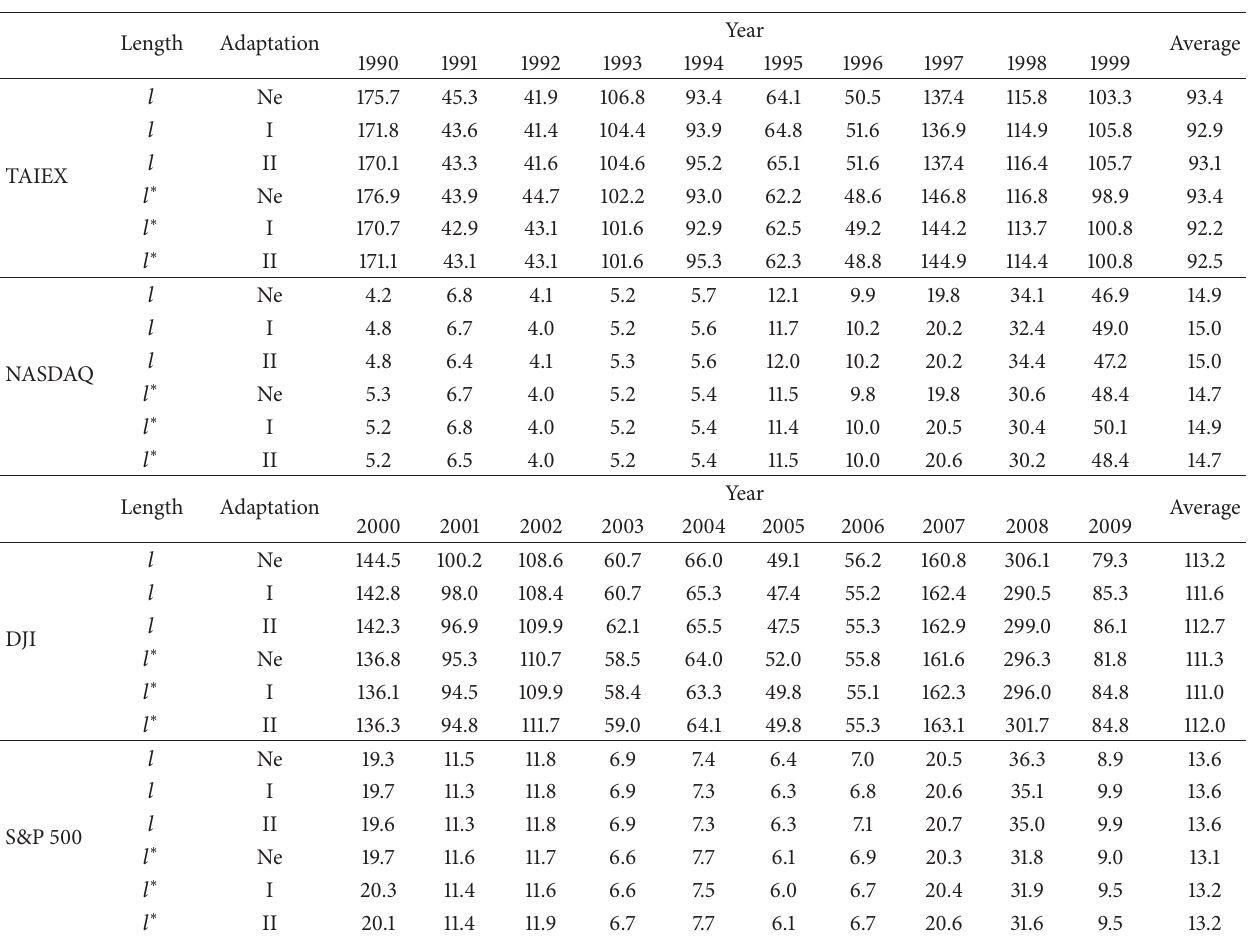
Table 5: Different results on TAIEX, NASDAQ, DJI, and S&P 500 for preprocessed data (Yu [22]). Length